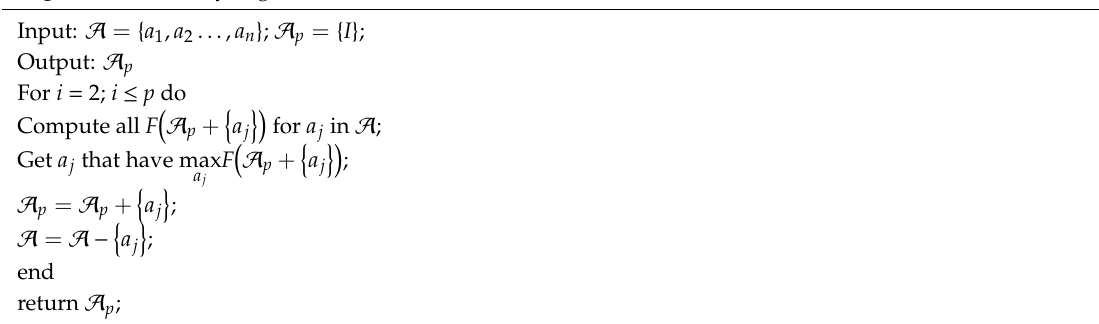
Algorithm 1 Greedy Algorithm in Model Inference Process Algorithm 1. Greedy Algorithm in Model Inference Process